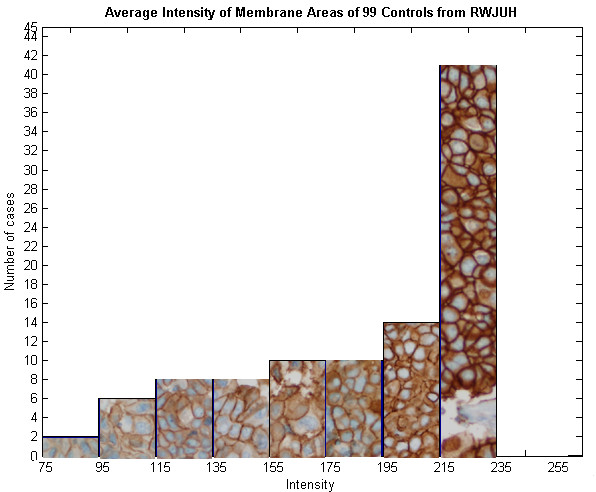
Variations on the Membrane Staining Intensities of Positive Control Specimens. This is a histogram showing the amount of specimens in each range of intensities. Each bar contains cases that lie within a 20 unit range of intensities. Though most positive controls stain darkly (215–235), there is a significant number of cases in which staining intensity deviates markedly from the mode. Consequently, features that take into account the intensity of the positive control are used in this study.